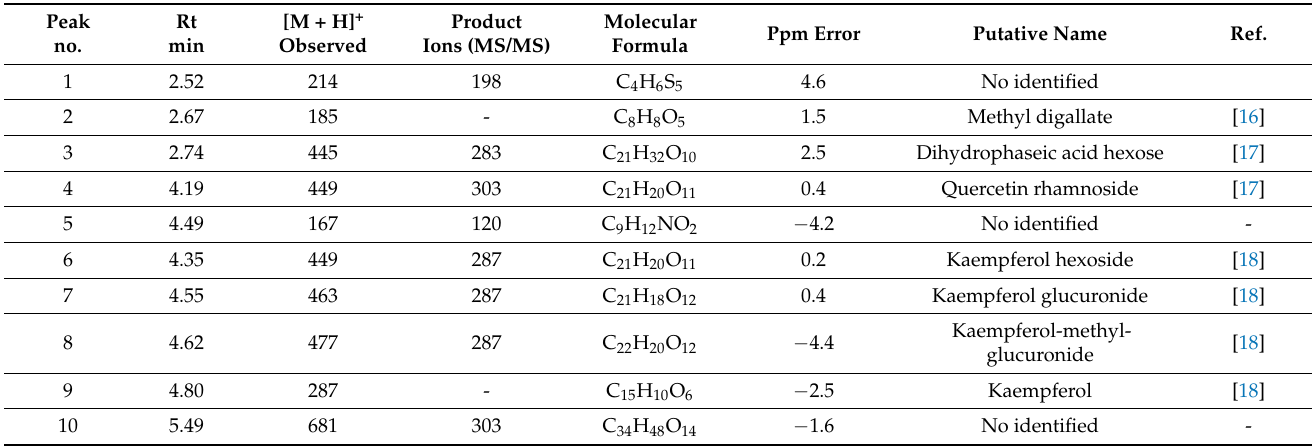
Table 2. UPLC-MS-ESI-QTOF identification of compounds from aqueous leaves extract of Spondias tuberora (Positive Mode).